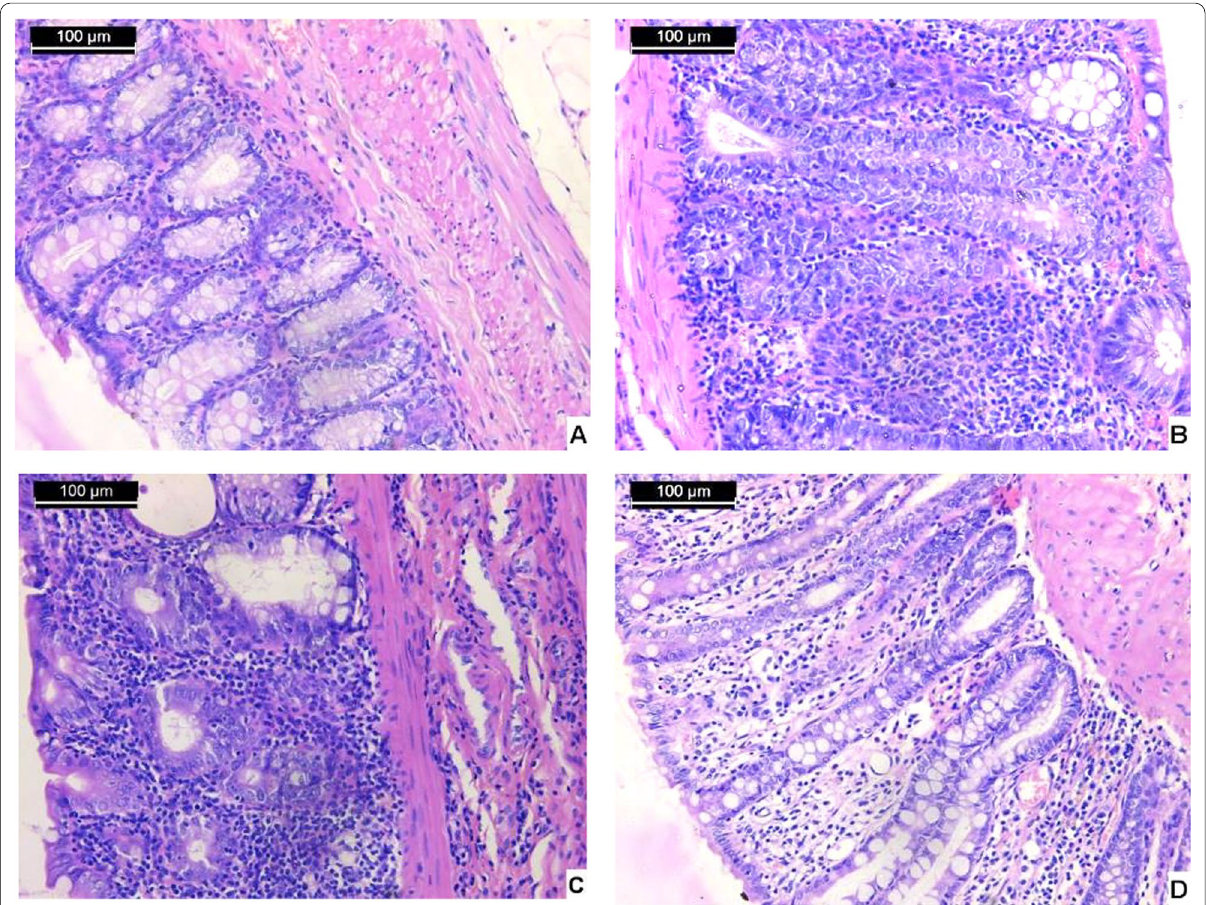
Fig. 3 Photomicrographs of colon specimens of the study groups stained by H&E ( 400). A : A photomicrograph of the control group showing × well-organized glands with normal mucosa. B : A photomicrograph of DMH group showing dysplasia, infiltration with mononuclear cells. C : A photomicrograph of 5FU treated rat showing infiltration with lymphocytes in the intestinal glands with the improvement of glandular morphology. D : A photomicrograph of FA-5FU combined treated rat showing normal intestinal glandular cells and normal covering epithelium